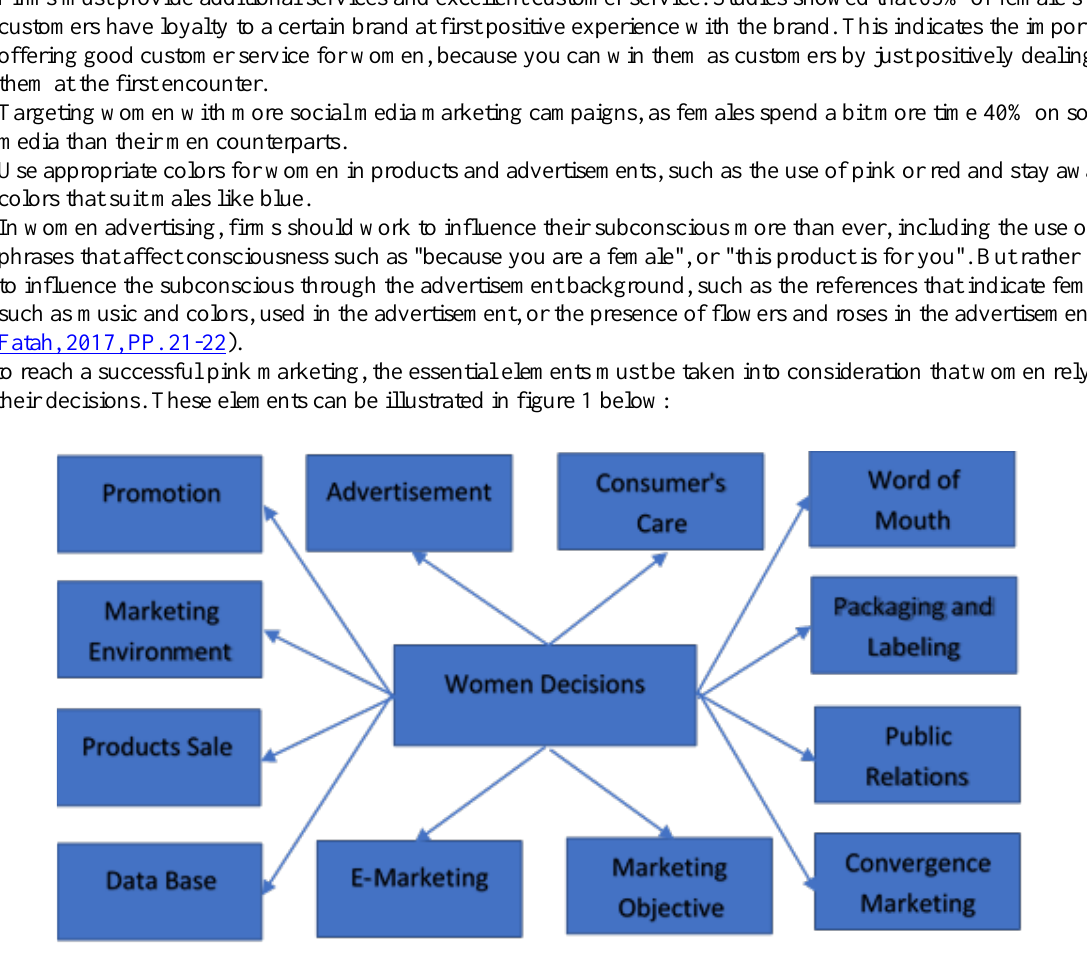
Figure 1: Elements of Women Buying Decision Source: Berletta, 2013, P.